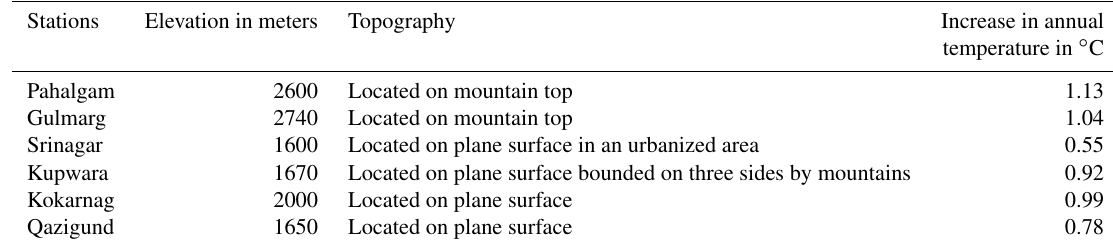
temperature in ◦ C